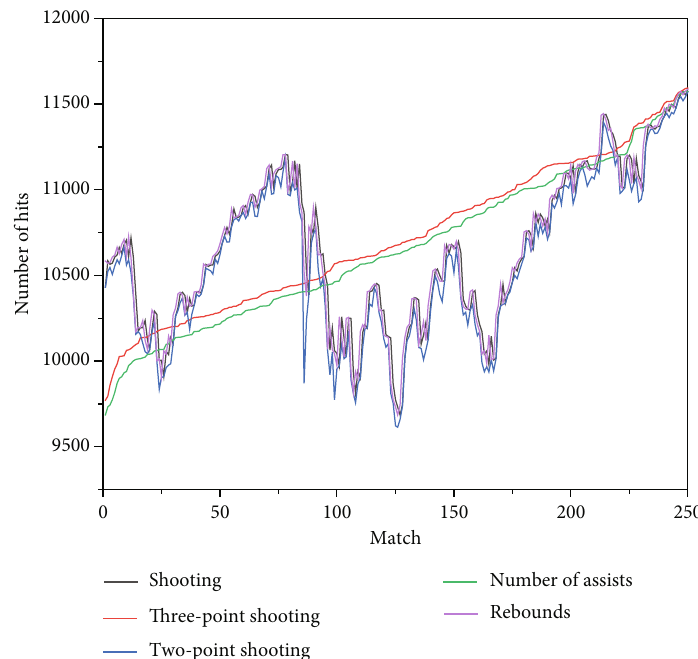
Figure 5: Competition